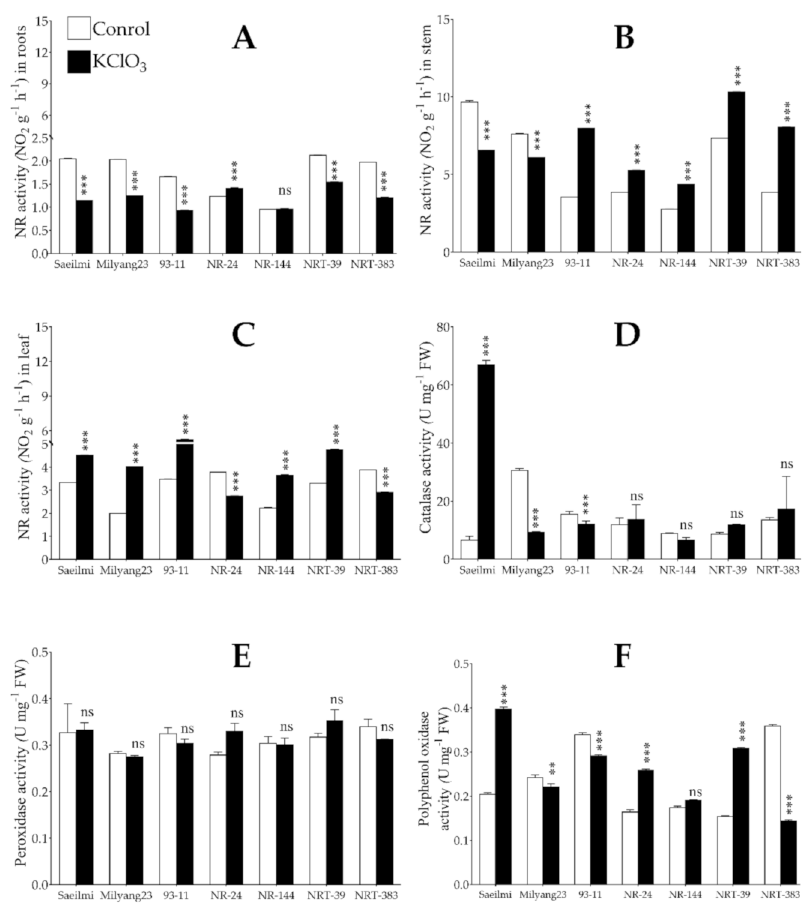
Figure 3. Changes in the activity of nitrate reductase (NR) and antioxidant enzymes. ( A – C ) Tissue- specific activity of the nitrate reductase (NR) enzyme in response to 0.5% potassium chlorate (KClO 3 ) 3 h after treatment, ( D ) catalase (CAT) activity, ( E ) peroxidase (POD) activity, and ( F ) polyphenol oxidase (PPO) activity in roots of rice seedlings exposed to KClO 3 . White bars are controls, while black bars are KClO 3 treated seedlings. Bars are mean values of triplicates ± SE. *** p < 0.001, ** p < 0.01, ns